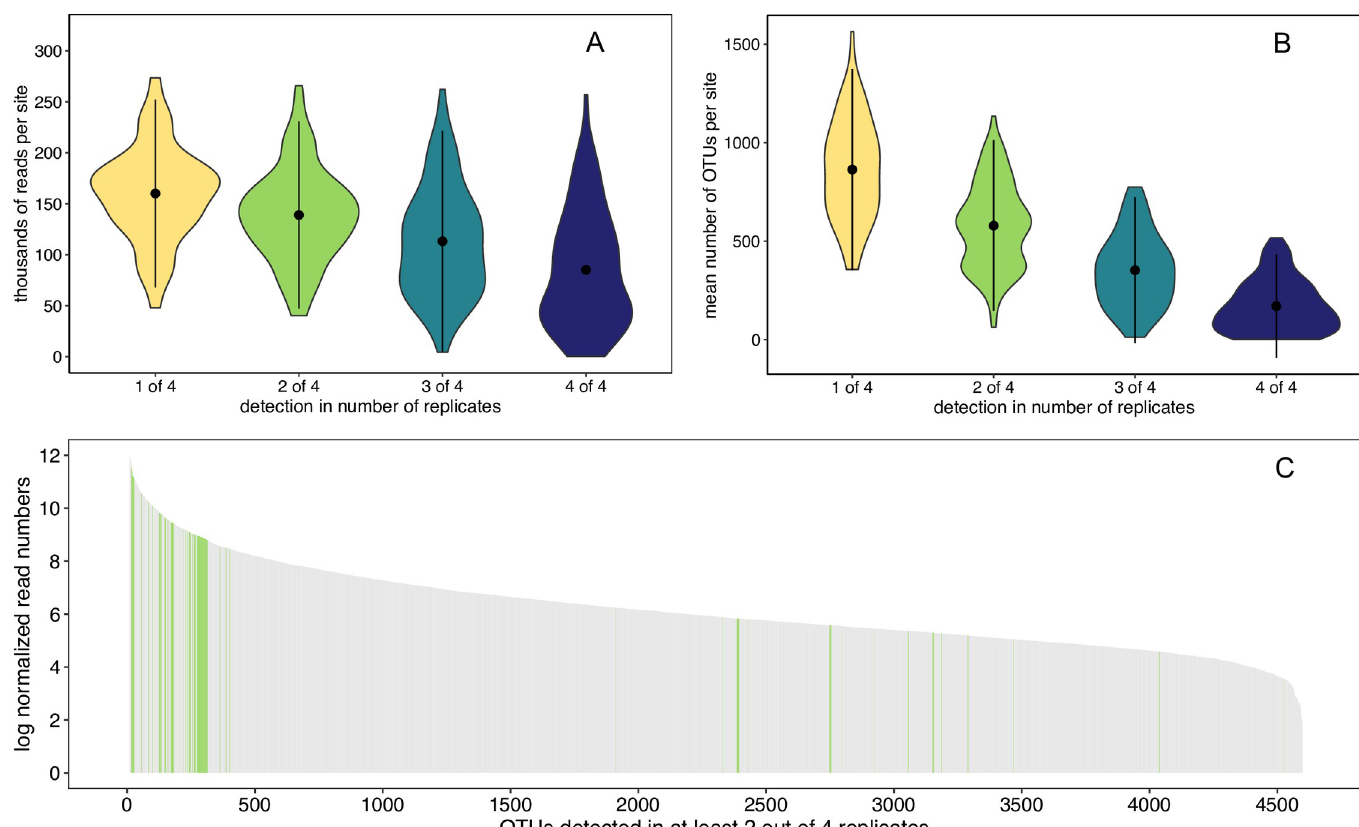
Fig 2. Filtering of raw sequencing data. Distribution of A) mean read number per sampling site and B) mean OTU number per sampling site using thresholds based on detection rate in the four field filter replicates. In the violin plots, the black dots indicate A) the mean read number over all sampling sites and B) the mean number of OTUs over all sites, the black vertical lines span the 95%-quantiles of all values. The detection rate is given with increasing stringency: Detection of an OTU in at least 1, 2, 3, or 4 out of 4 filter replicates per site, respectively. C) Read abundance distribution of OTUs (n = 4599) detected in at least 2 out of 4 replicates per site. Read abundances of OTUs that were taxonomically assigned to indicator taxa are highlighted in